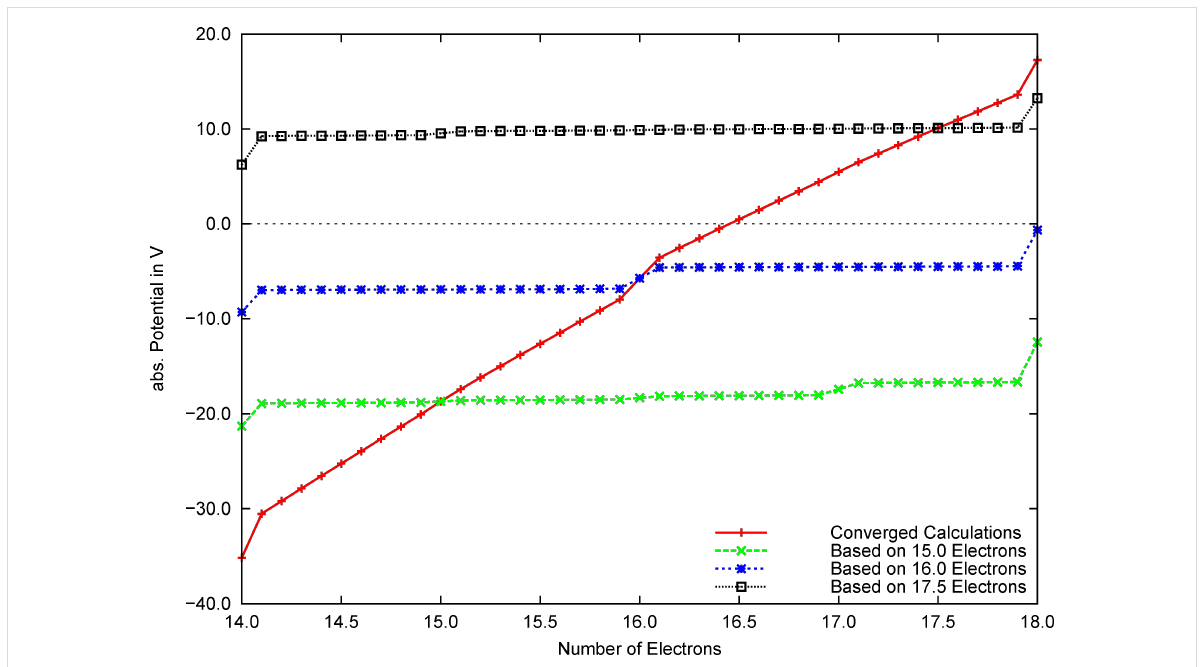
Figure 2: Change of the absolute potential for O 2 depending on the number of electrons, calculated numerically and approximated by Equation 3, res- pectively.